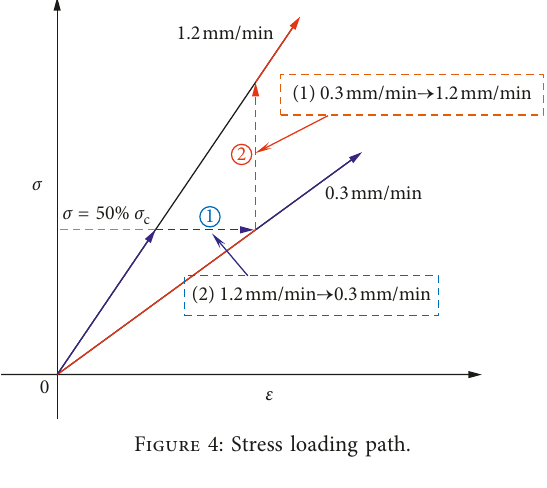
Figure 4: Stress loading path.